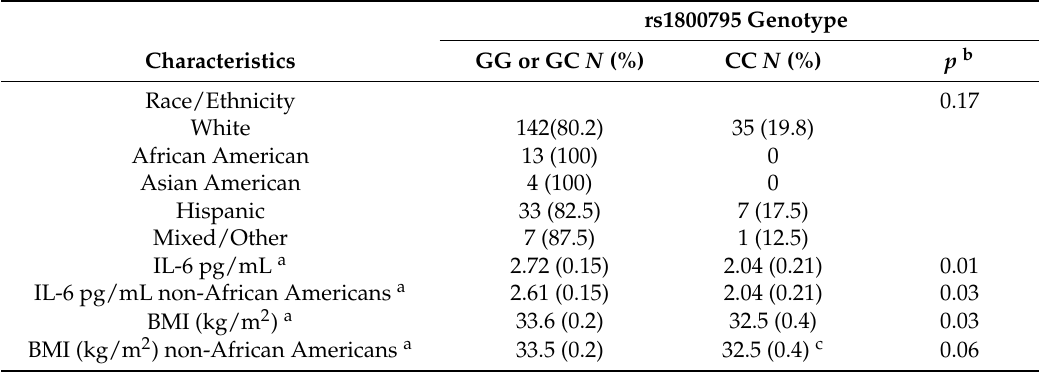
Table 1. Baseline characteristics in 242 participants.